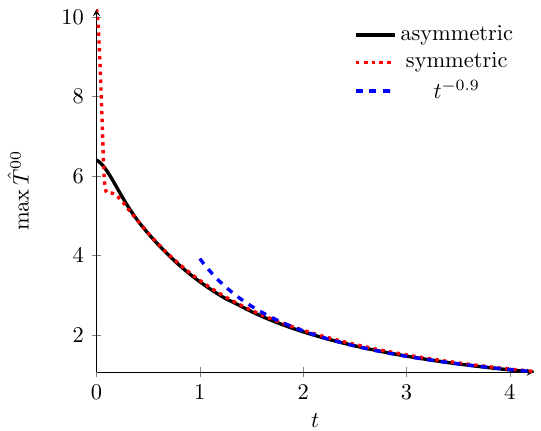
Figure 3 . Comparison of time dependent amplitudes of the energy density maxima (associated with the thinnest shock) in a symmetric collision of two narrow shocks of width w = 0 : 075 (solid blue line) and an asymmetric collision of shocks having widths w = 0 : 075 and w = 0 : 25 (dashed red line), with all incoming shocks having the same transverse energy density. Also shown is a t (cid:0) 0 : 9 asymptotic form (long dashed blue line). Except for short time transients ( t . 0 : 3), the maxima